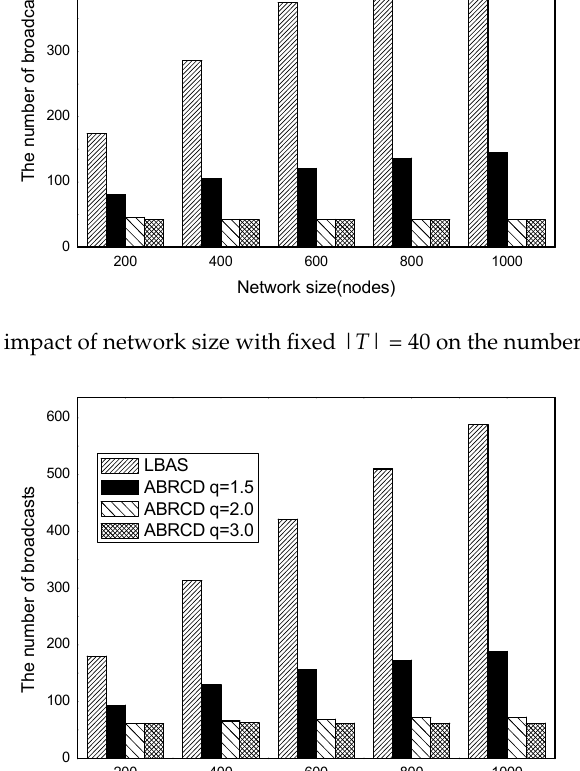
Figure 34. The impact of network size with fixed | T | = 60 on the number of broadcasts.